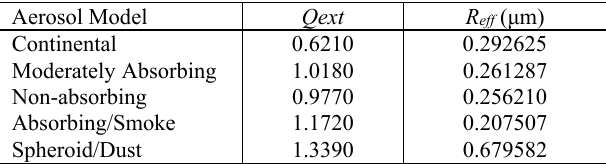
Table 1. Extinction properties of the aerosol